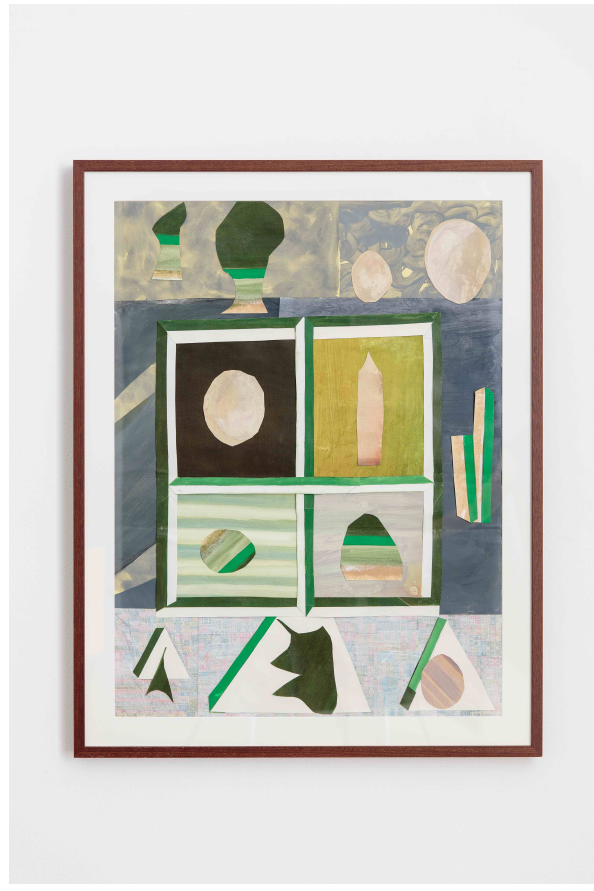
Figure 5: Kieran Drury, Take the first left hand , 2016, Acrylic and oil on paper, 90 x